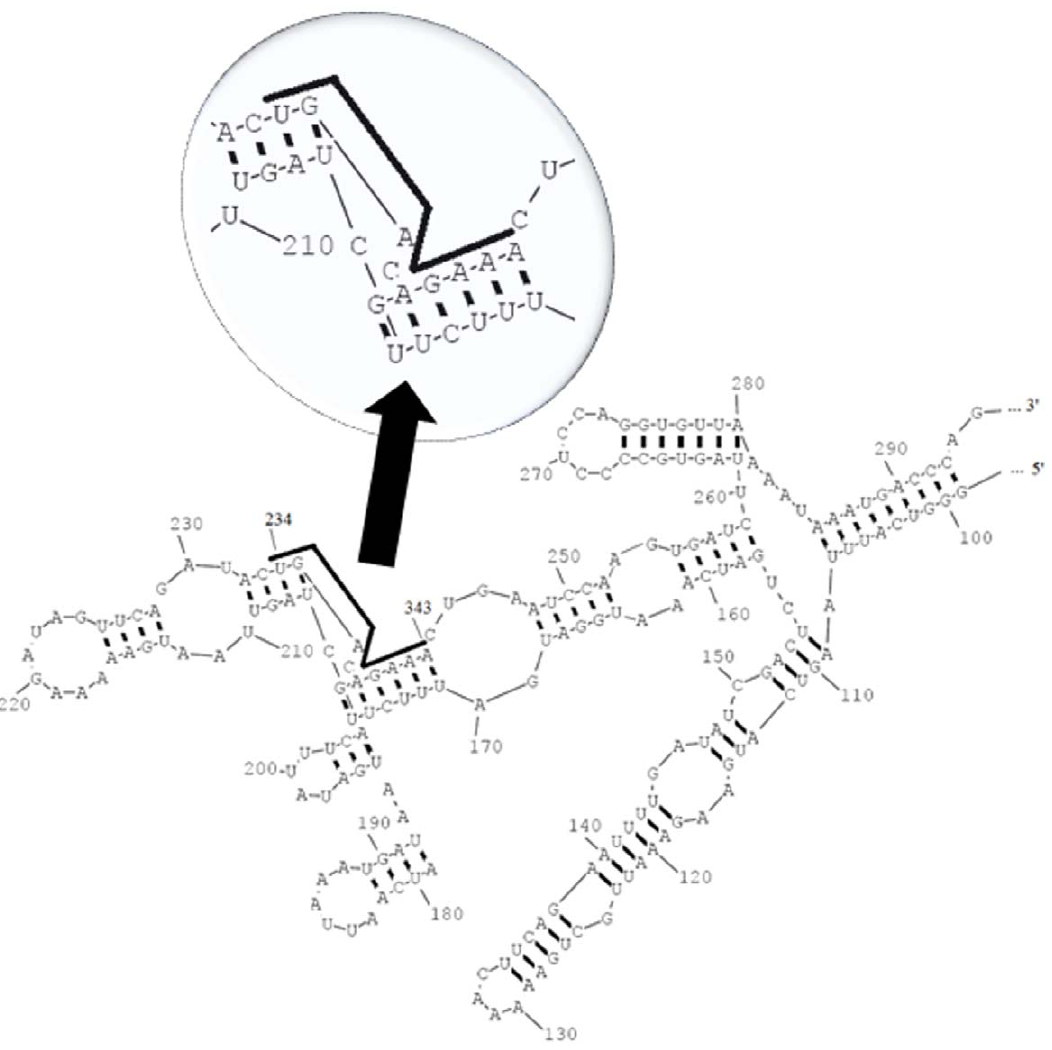
Figure 1. Secondary structure of E.coli RNA polymerase primary s 70 mRNA. The target region of the 10-mer peptide nucleic acid (nucleotides 234–243) is indicated by the bold line.